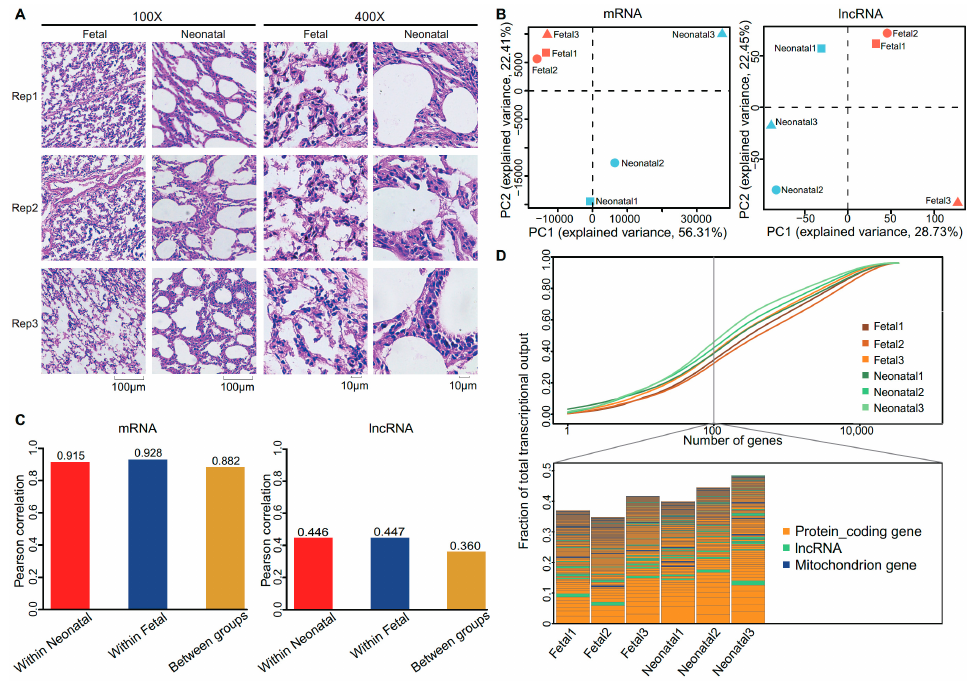
Figure 1. ( A ) Magnified images of the lungs in fetal and neonatal groups (Left: 100×; Right: 400×). Rep1, rep2, and rep3 are representative of tripartite biological replicates. ( B ) Principal component analysis (PCA) was performed on the expression levels of messenger RNA (mRNA) and long non-coding RNA (lncRNA) with log 2 -transformed FPKM (fragments per kilobase per million mapped reads) values. ( C ) Pearson correlation coefficients between samples in the same group or between two groups. ( D ) The complexity of total (mRNA and lncRNA) transcripts. Top: Cumulative measures of the fraction of total transcripts contributed by mRNA and lncRNA (all transcripts were sorted from most-to-least). Bottom: Biological type and relative contribution to total transcripts of the top-100 expressed genes or transcripts. Height of the bar shows the relative contribution of transcripts to the total. PC: Principal